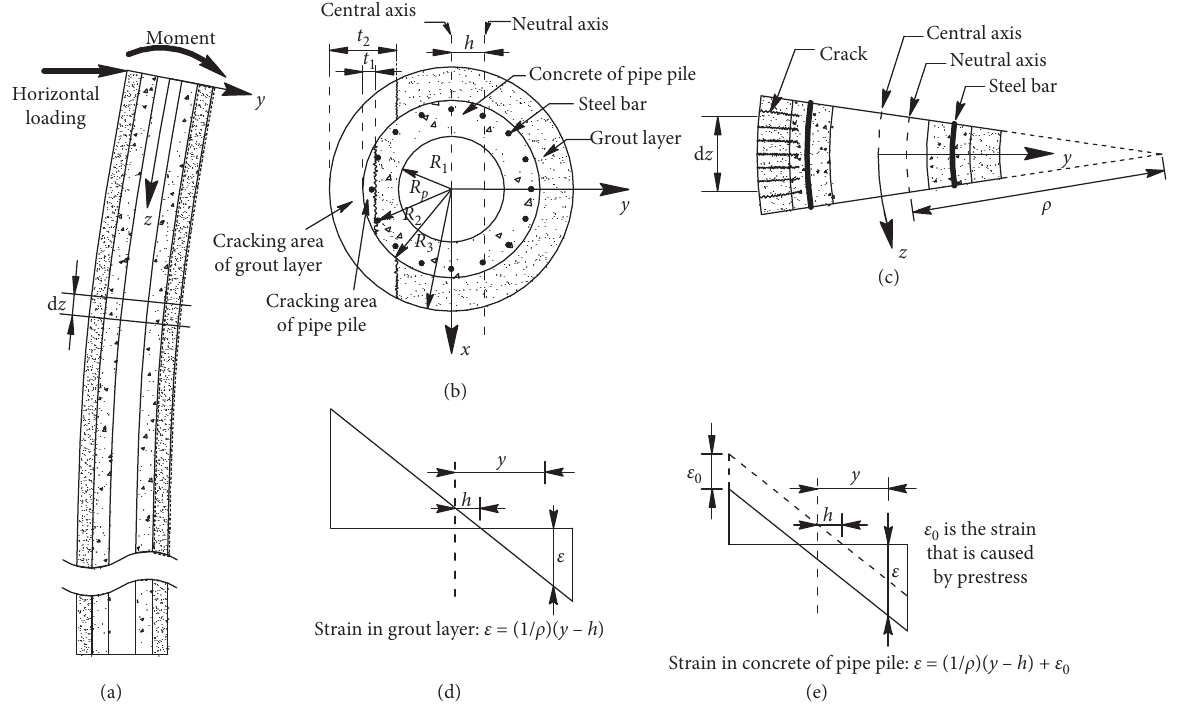
Horizontal loading